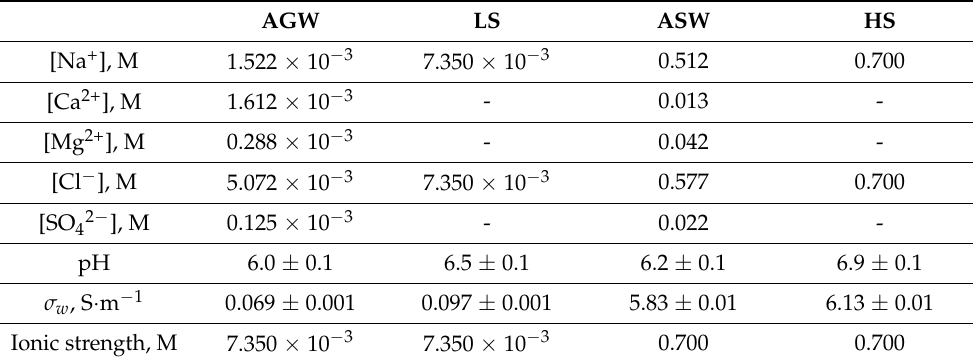
Table 1. Chemical composition, equilibrium pH and electrical conductivity of tested solutions. The solution pH was measured using Mettler Toledo FiveGo pH meter, the electric conductivity of all so- lutions was measured using Jenway 4520 conductivity meter with the corresponding errors reflecting the instrument inaccuracy and measurement repeatability. AGW and LS solutions were prepared from high-salinity stock solutions of 0.735 M ionic strength, hence, errors in molar concentrations of all four tested solutions resulting from inaccuracies in weighing of the constituent salts are estimated at ± 3% of the reported values. AGW LS ASW HS [Na + ], M 1.522 × 10 − 3 7.350 × 10 − 3 0.512 0.700 [Ca 2+ ], M 1.612 × 10 − 3 - 0.013 - [Mg 2+ ],